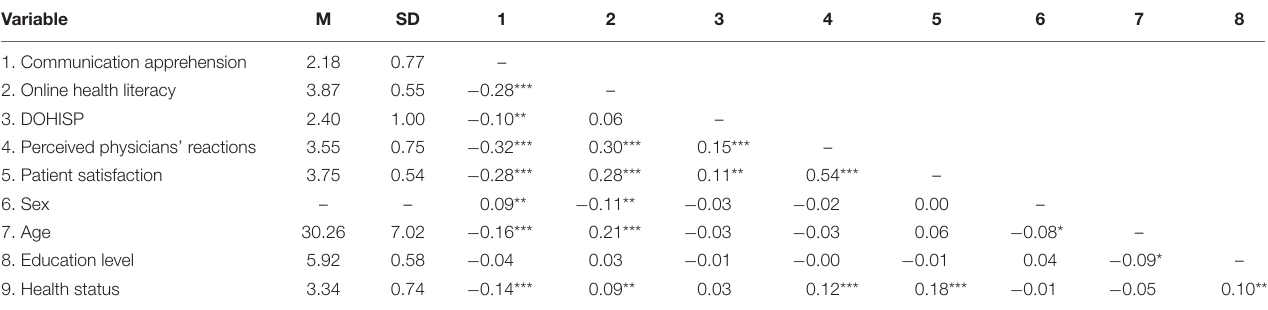
TABLE 2 | Mean, standard deviation, and zero-order correlations ( N = 818).